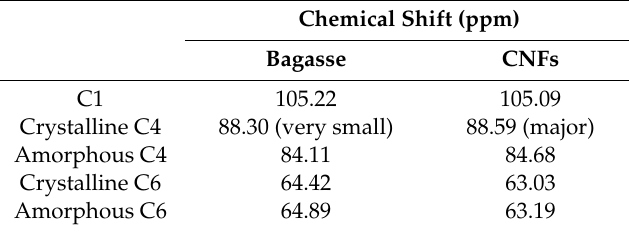
Table 2. Resonance distribution of the main peaks in the 13 C CPMAS NMR spectra of the bagasse fiber and CNFs.